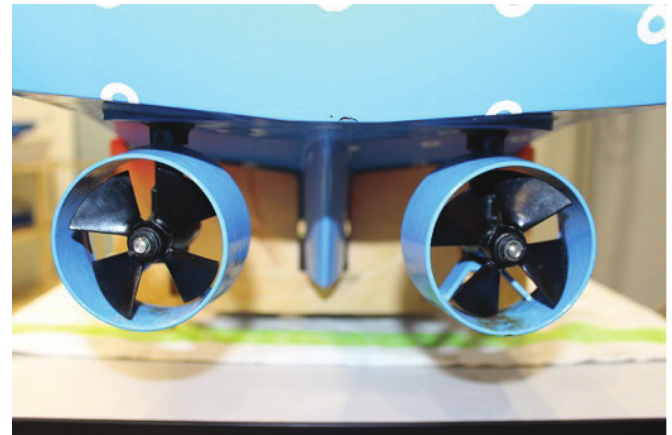
Figure 2. Tito Neri azimuthing thrusters from astern.